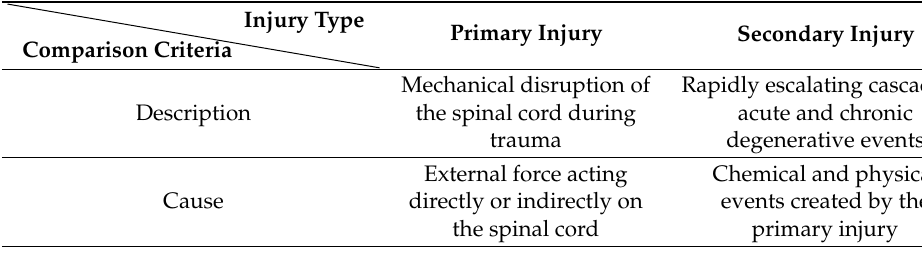
Table 1. Comparison between primary and secondary spinal cord injury (SCI). Created based on information from